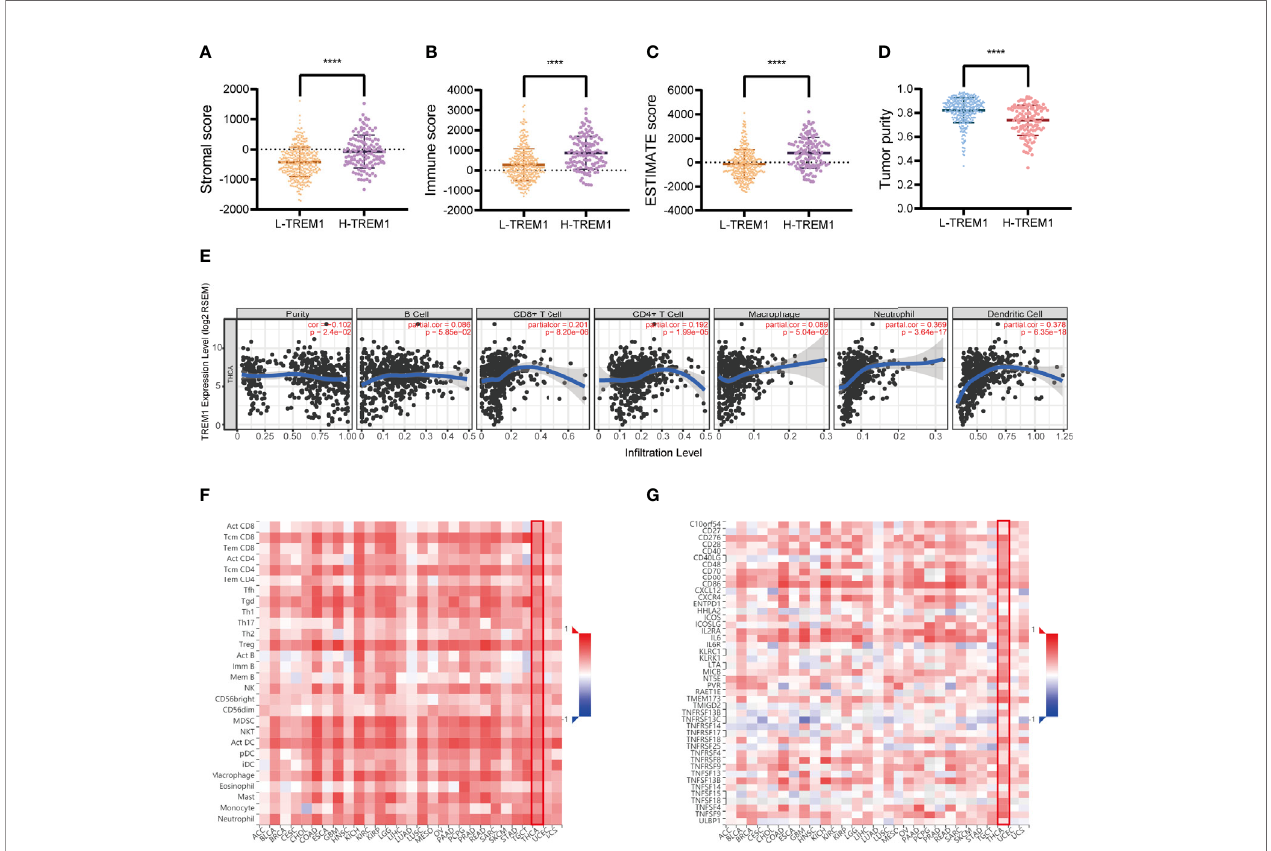
FIGURE 3 | TREM-1 is closely related to immunity in PTC. ESTIMATE analysis of (A) stromal scores, (B) immune scores, (C) ESTIMATE scores and (D) tumor purity between the L-TREM-1 and H-TREM-1 groups. (E) TIMER analysis of purity-corrected partial Spearman correlations between the expression of TREM-1 and the in fi ltration of 6 types of immune cells in the THCA cohort. (F) Correlation analysis between the expression of TREM-1 and 28 types of TILs across human cancers via TISIDB. (G) Correlation analysis between the expression of TREM-1 and the levels of immunostimulators across human cancers via TISIDB. ****P < 0.0001